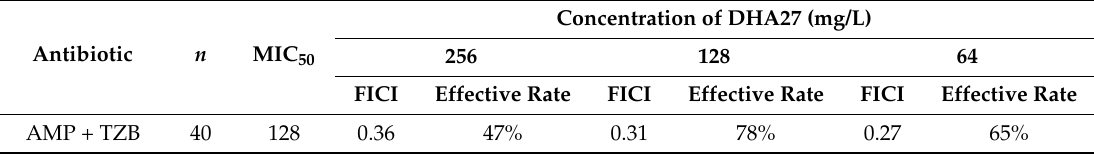
Table 2. Effect of DHA27 on antibacterial activity of AMP against 40 clinical E. coli strains.